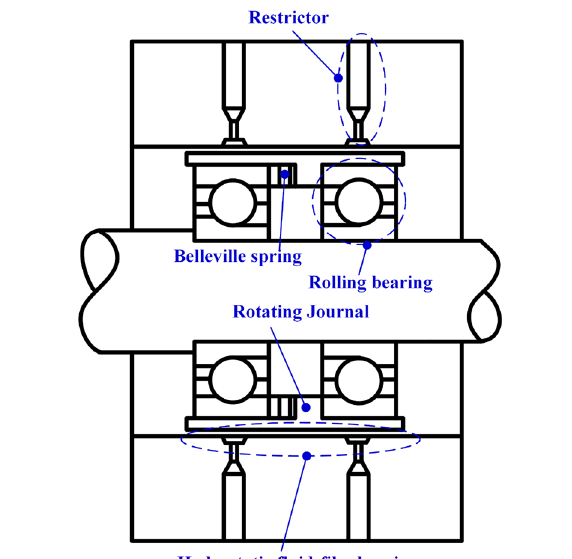
Figure 5 Combination bearing with rolling and hydrostatic fluid-film bearings [37]